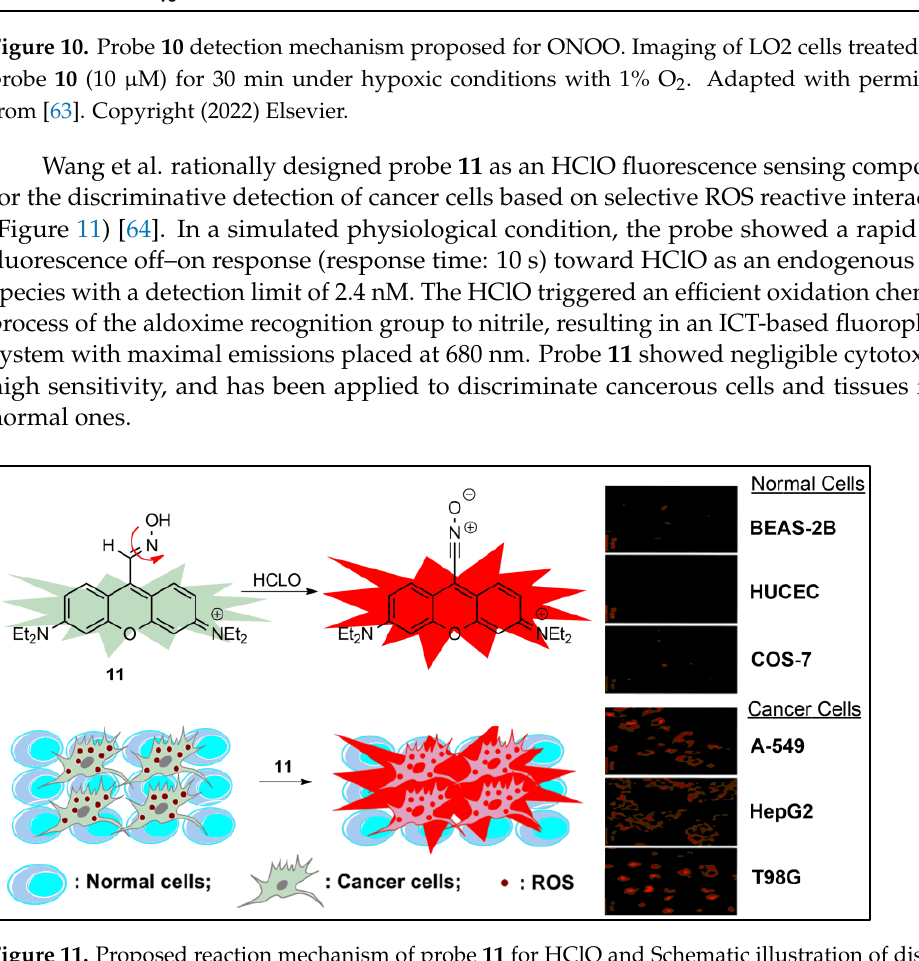
Figure 11. Proposed reaction mechanism of probe 11 for HClO and Schematic illustration of discriminating cancer cells from normal cells using 11 . Fluorescence images of 11 -loaded (2 μ M, 20 min) cancer cells and normal cells. Adapted with permission from [64]. Copyright (2021) Elsevier.